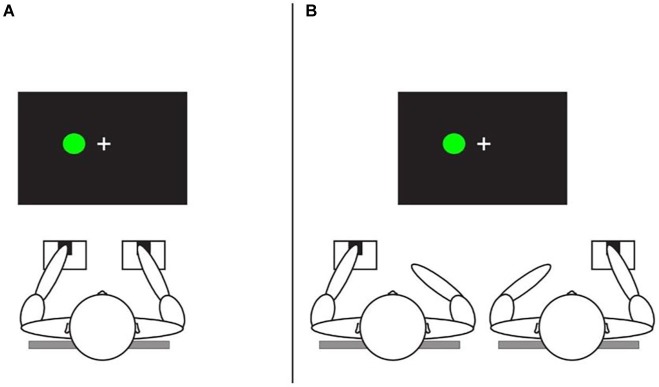
Schematic representation of standard Simon task (A) and joint Simon tasks (B) (Ruissen and de Bruijn, 2016).